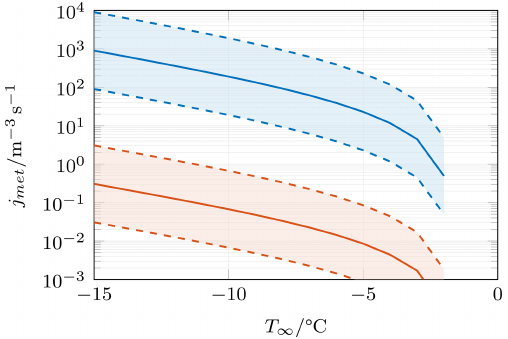
Figure 10. Limiting cases for the nucleation rate j met . The swept- volume-limited estimate based on the arguments of Prabhakaran et al. (2020) and evaluated from the present data according to Eq. (27) is shown for C expo = 10 (solid blue line), with the shaded area depicting the values obtained for 1 < C expo < 100. The exposure-time-limited estimate defined in Eq. (29), which is di- rectly linked to the ice enhancement factor, is shown for τ nucl = 10s (solid red line) and the range 1s < τ nucl < 100s (shaded area).